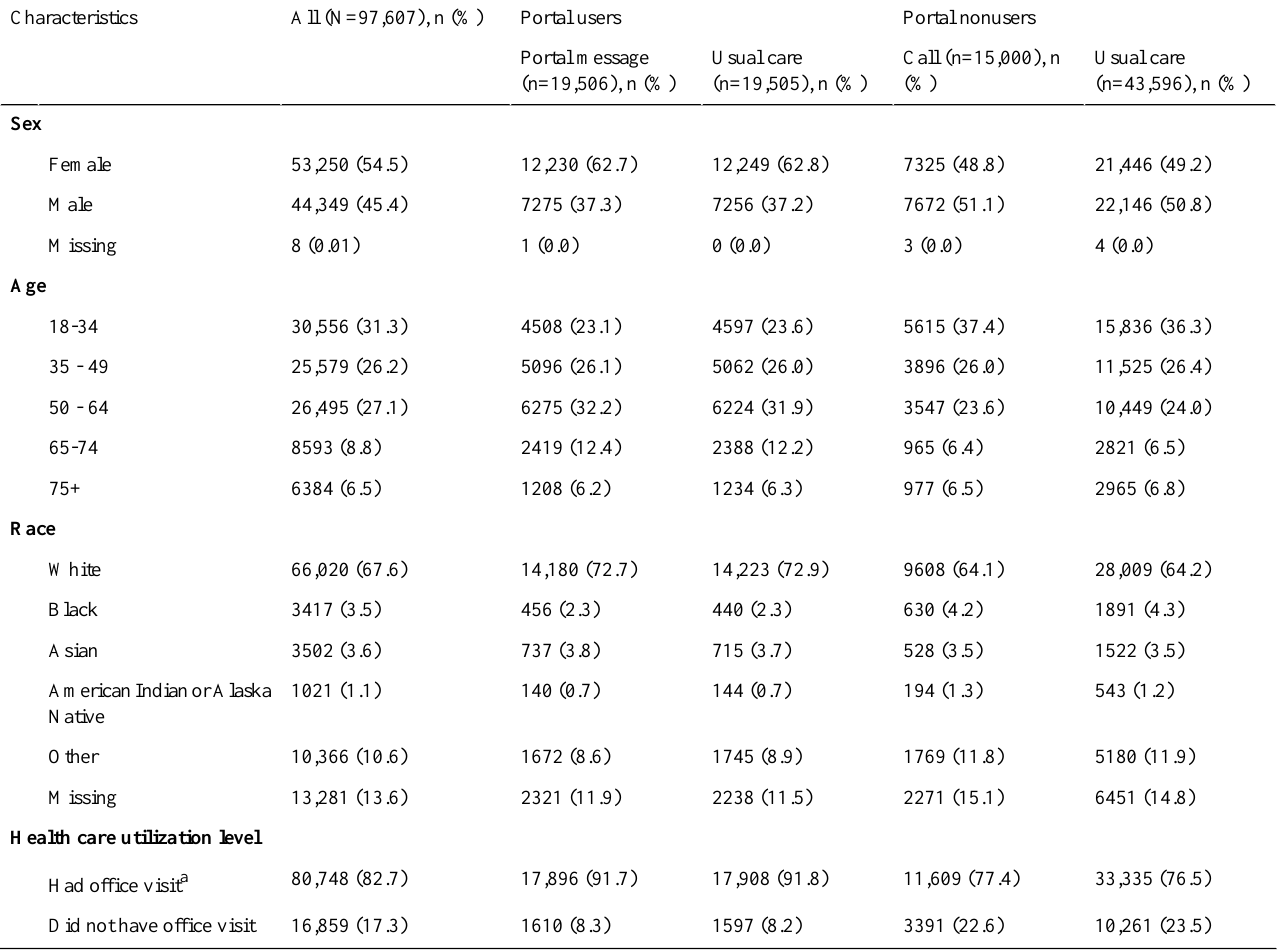
Table 1. Baseline characteristics of